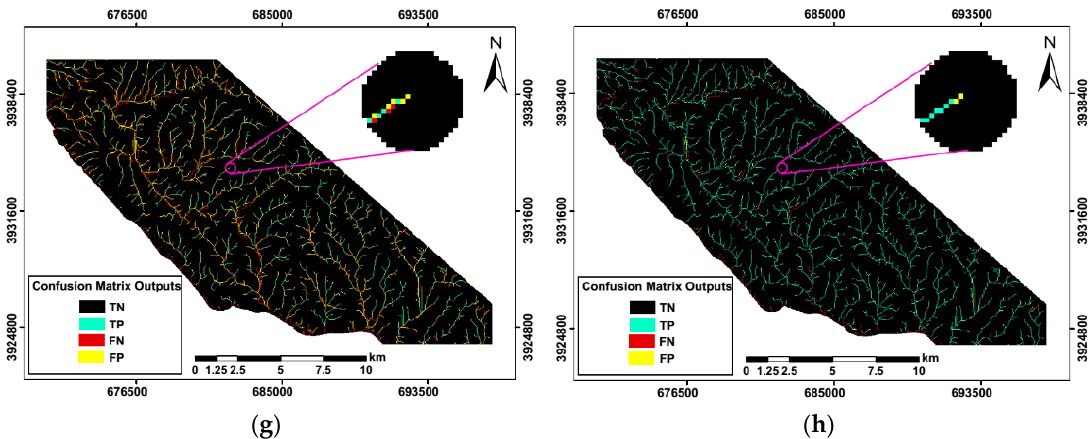
Figure 6. Confusion matrix outcomes resulting from comparing channel networks extracted from: ( a,b ) LiDAR DTM and PALSAR DEM 12.5 m at an area threshold (AT) corresponding to 25 pixels and pixel buffer tolerance value (PBTV) of 0 and 3 pixels, respectively; ( c,d ) LiDAR DSM and PALSAR DEM 12.5 m using an AT corresponding to 25 pixels and PBTV of 0 and 3 pixels, respectively; ( e,f ) LiDAR DTM and PALSAR DEM 28.5 m using an AT corresponding to 100 pixels and PBTV of 0 and 3 pixels, respectively, and ( g,h ) LiDAR DSM and PALSAR DEM 28.5 m using an AT corresponding to 100 pixels and PBTV of 0 and 3 pixels, respectively.